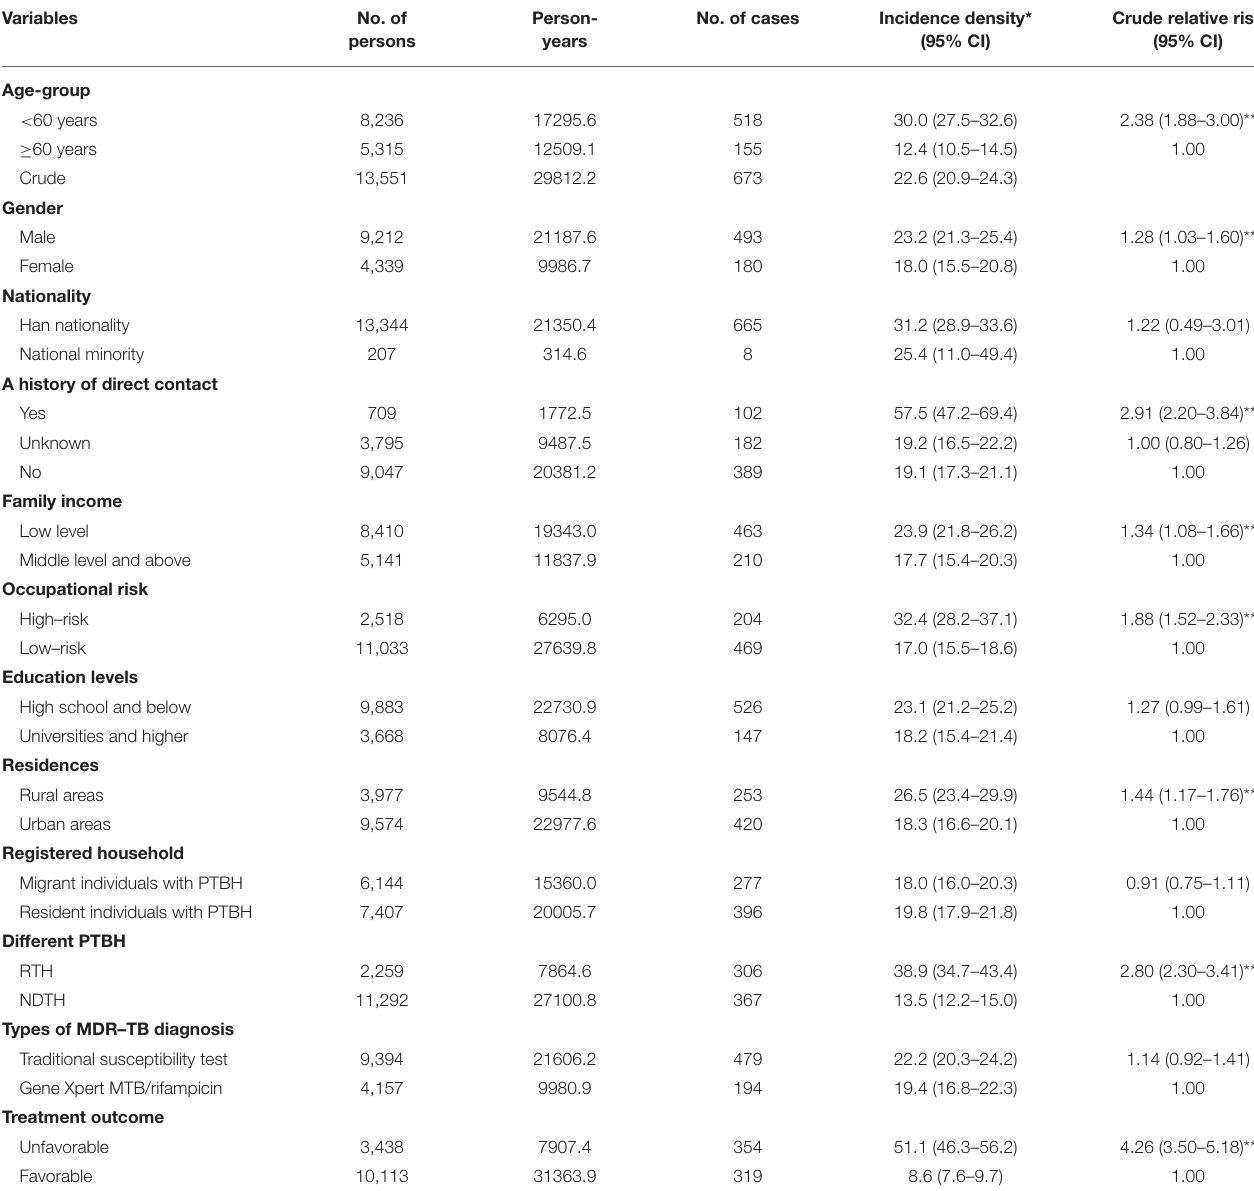
TABLE 3 | Incidence density of MDR-TB among individuals with PTBH in Hangzhou, China ( N = 13,551).